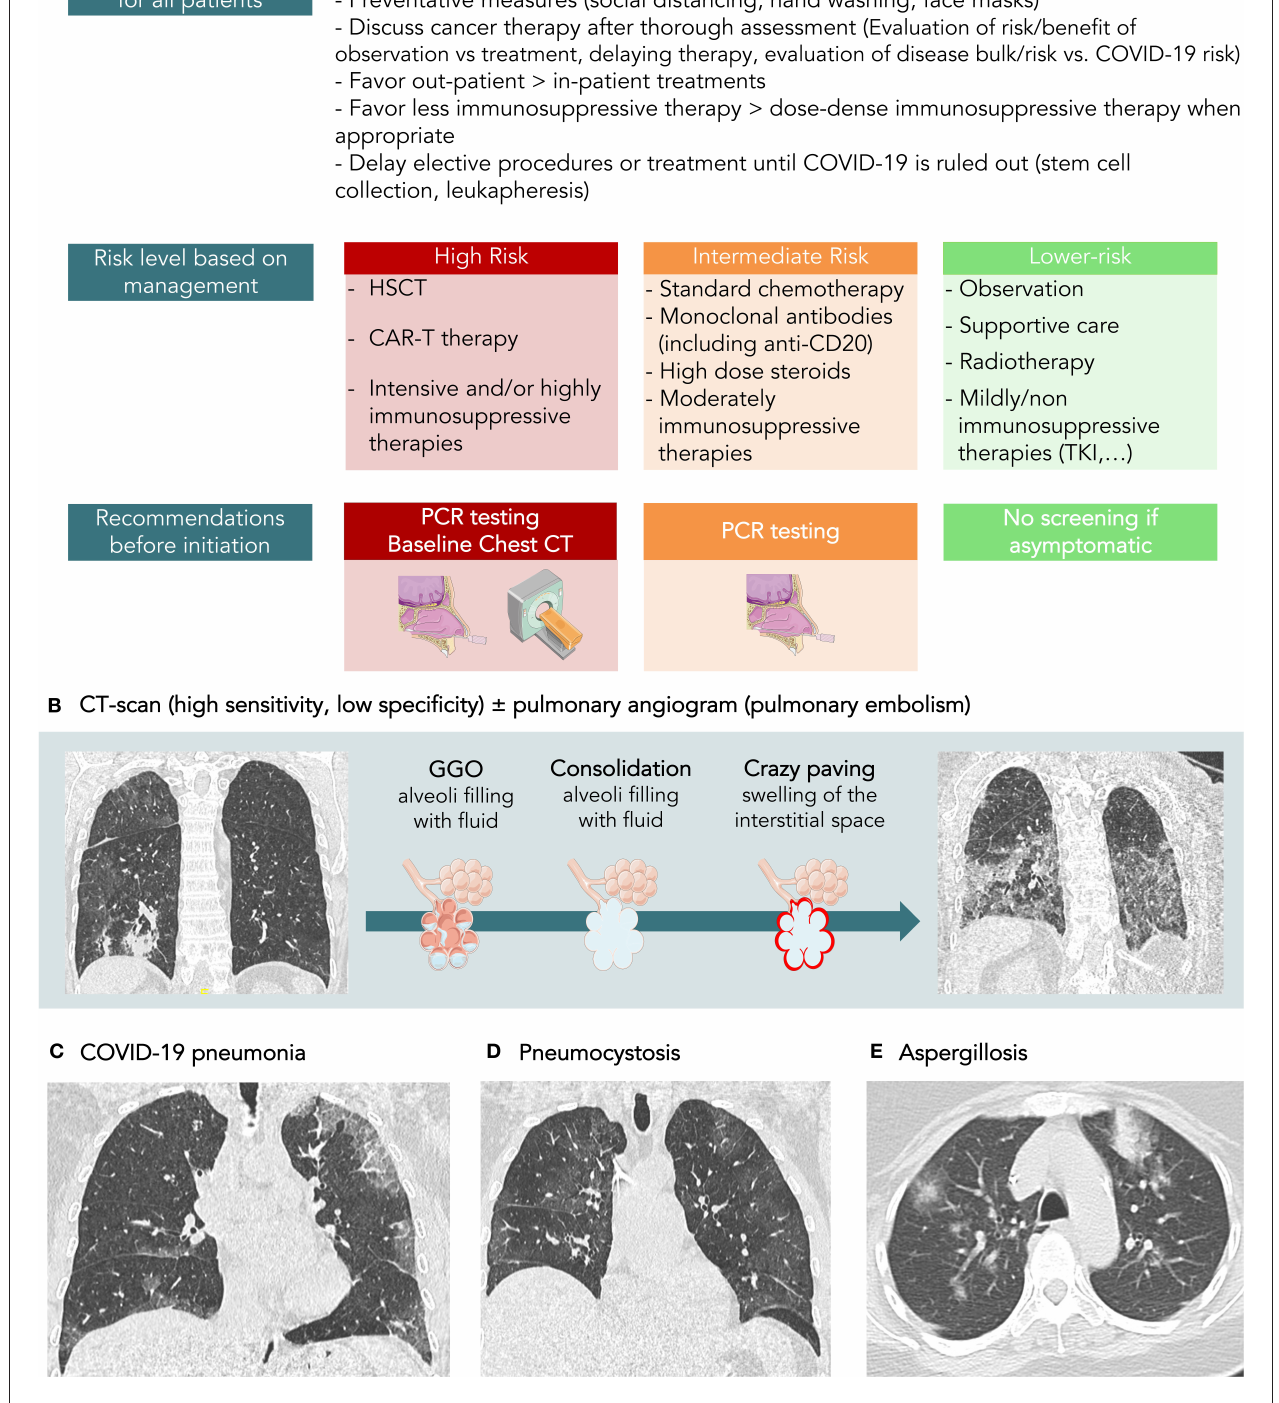
Frontiers in Oncology | www.frontiersin.org